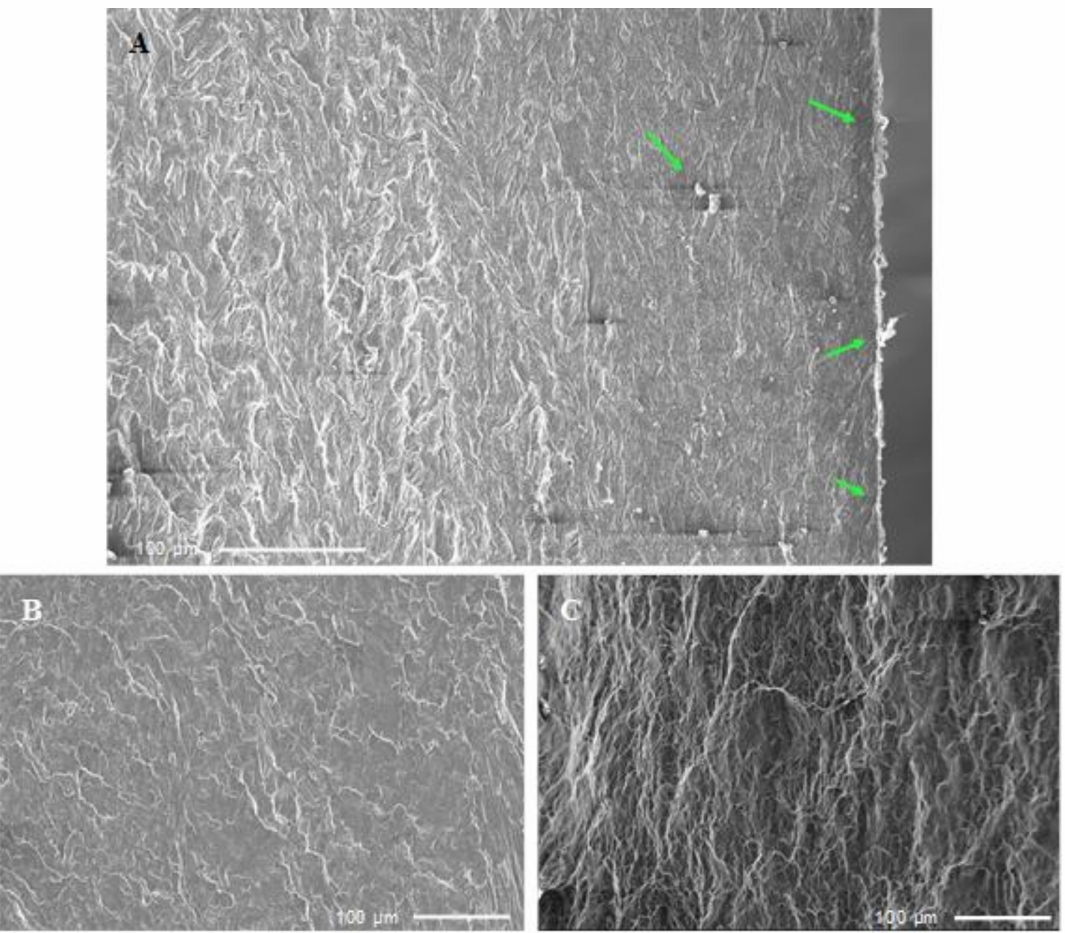
Figure 11. Fatigue fracture morphologies of the anodized specimen tested in air at 105 MPa. The micrographs ( A – C ) correspond to the three different regions pointed out in Figure